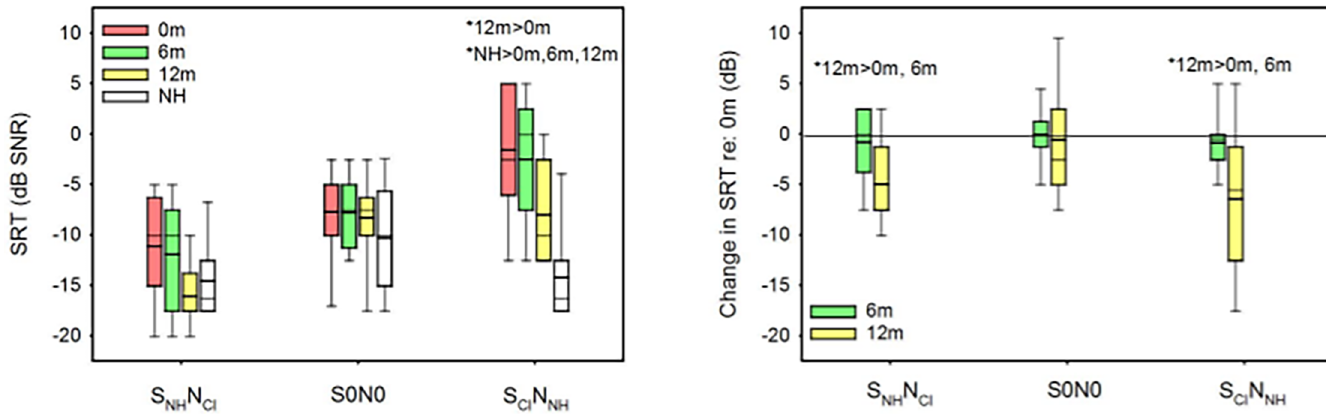
Fig 3. SRTs measured for the three spatial conditions. A: Mean SRTs for different spatial conditions. The colored bars show SSD-CI performance at Base (red), 6m (green), and 12m (yellow). The white bars show performance for the NH control group. B: Mean change in SRTs for SSD CI subjects, relative to baseline; values < 0 indicate improved speech understanding in noise, relative to baseline. In both panels, the boxes show the 25 th and 75 th percentiles, the error bars show the 5 th and 95 th percentiles, the thick line shows the median, and the thin line shows the mean. The asterisks show significant differences between test sessions or between subject group (p <